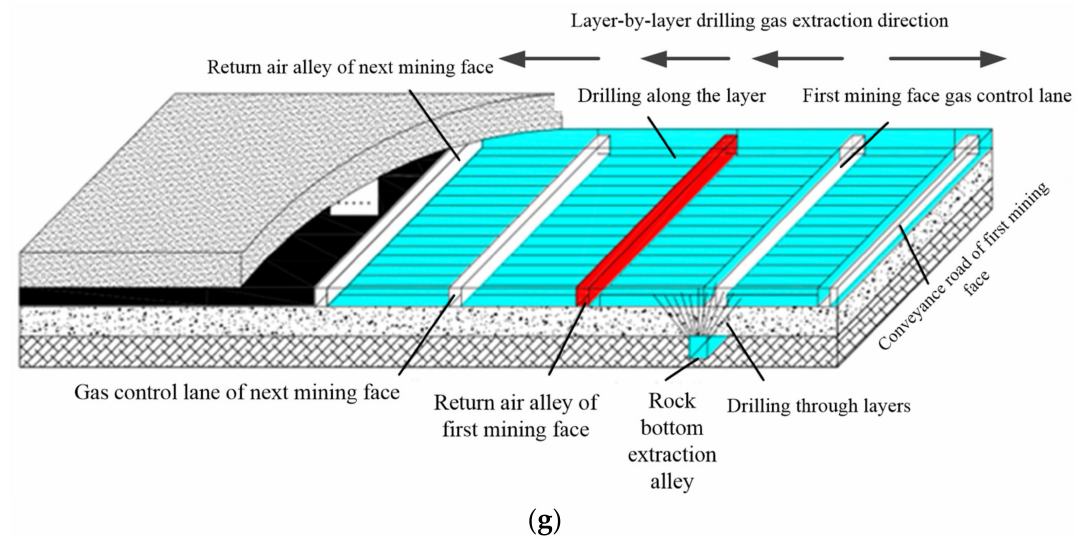
Figure 1. Process of “L-H method” ( a ) Schematic of the “L-H method” mining system; ( b ) Schematic diagram of drilling through the rock-bottom extraction roadway; ( c ) Schematic of gas control lane; ( d ) Drawing of gas drainage along the formation; ( e ) Schematic of gob-side entry; ( f ) Schematic of gas control lane in the lower section; ( g ) Schematic of gas control lane in the lower